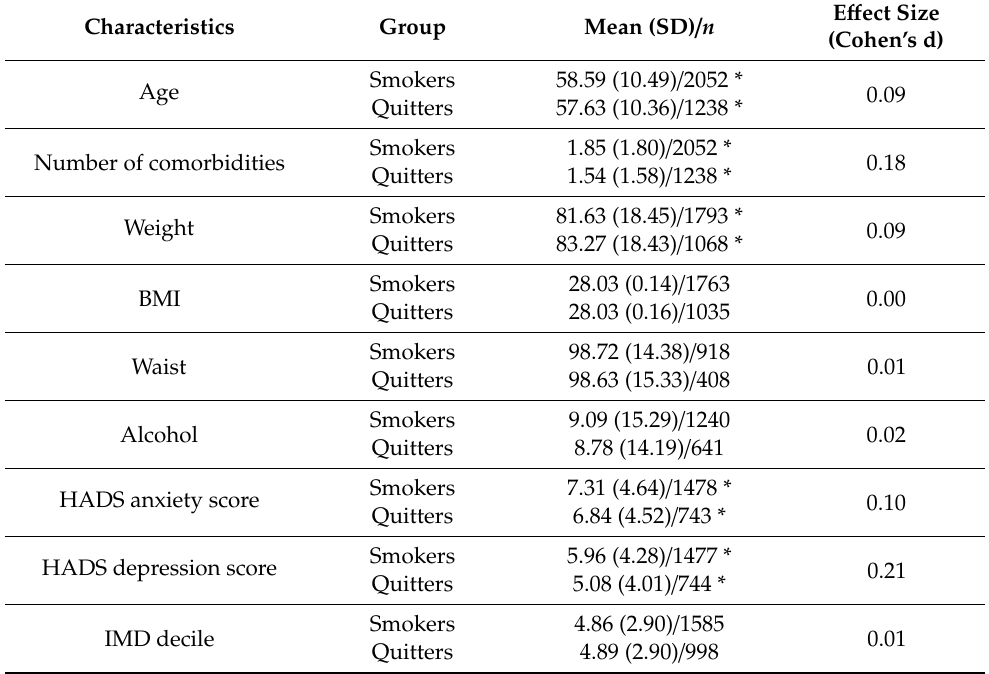
Table 2. Baseline characteristics of smokers and quitters participating in cardiac rehabilitation (continuous